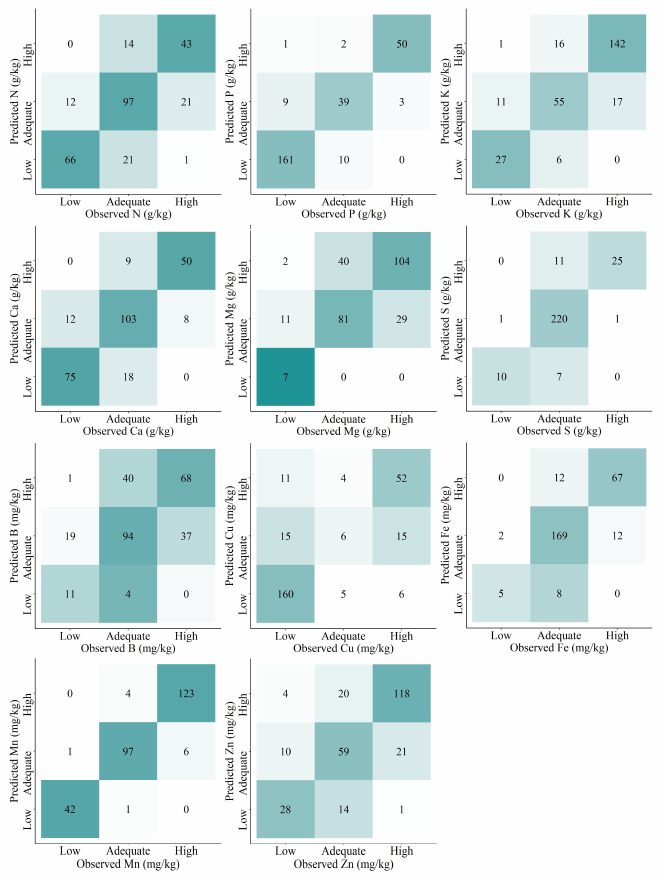
Figure 3. Confusion matrix for the best prediction models of Eucalyptus spp. leaves macro and micronutrients per class of nutrient status based on portable X-ray fluorescence (pXRF) elemental data. Darker colors indicate higher number of samples in that class.